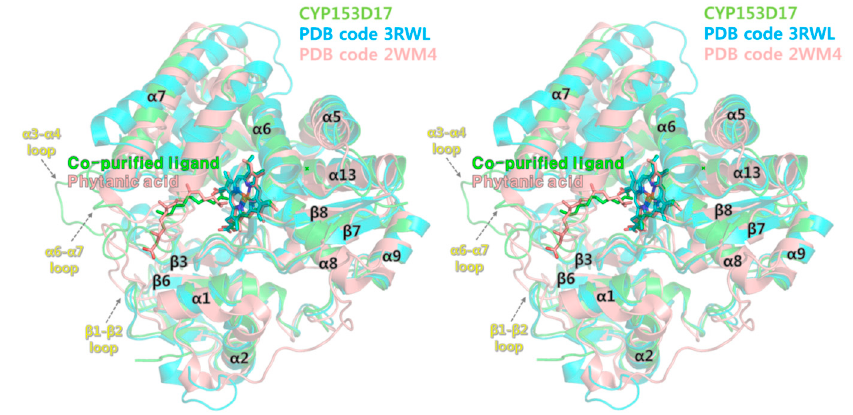
Figure 5. Stereo view of the crystal structures of P450pyr (PDB code, 3RWL; blue) and phytanic acid–bound CYP124 (PDB code, 2WM4; salmon) superimposed on the CYP153D17 structure (green). Secondary structure elements were named based on the CYP153D17 structure.